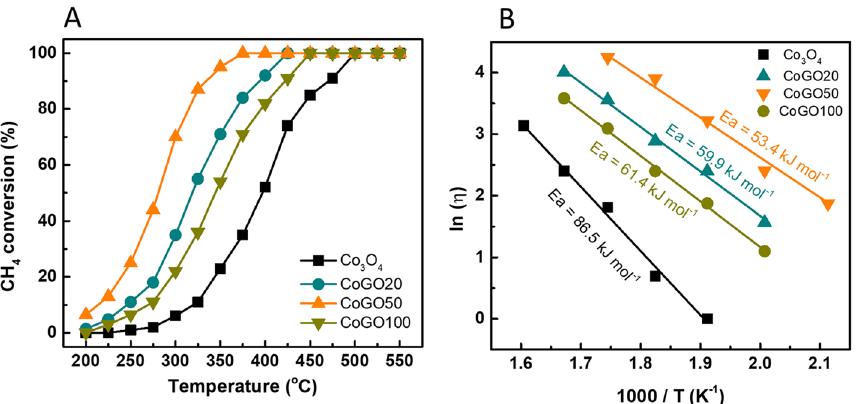
Figure 5. ( A ) Methane conversion over Co 3 O 4 , CoGO20, CoGO50 and CoGO100 catalysts and ( B ) Temperature dependence of CH